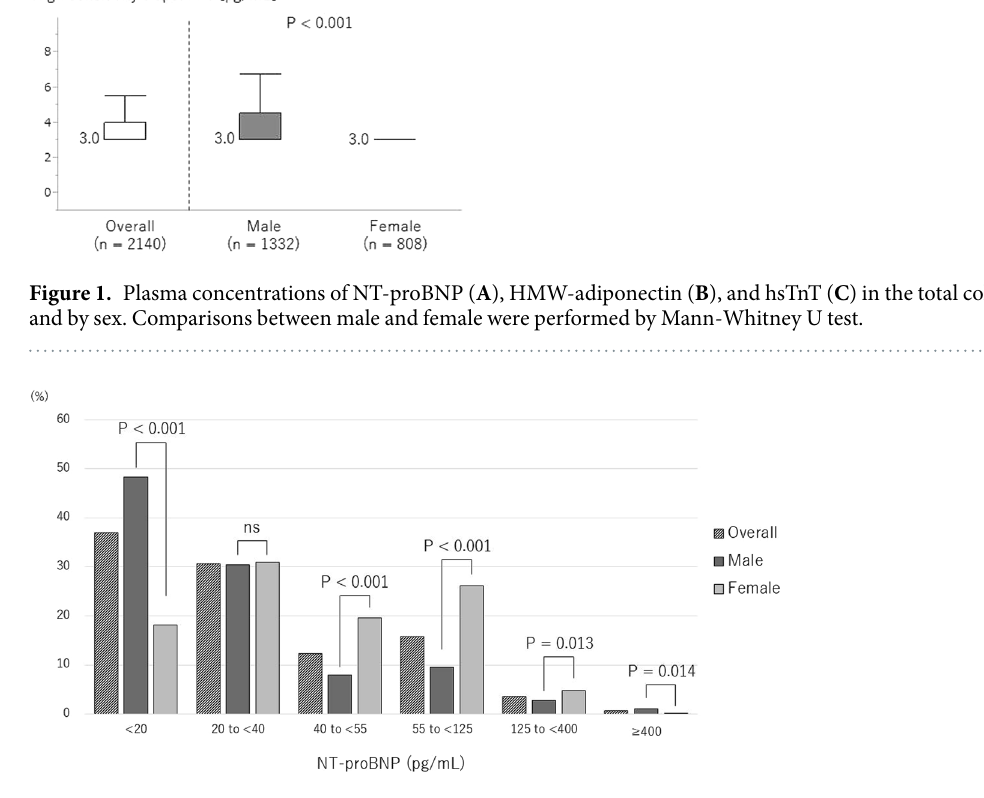
Figure 2. Distribution of NT-proBNP concentration. A sex difference was evident in each category except 20 to < 40